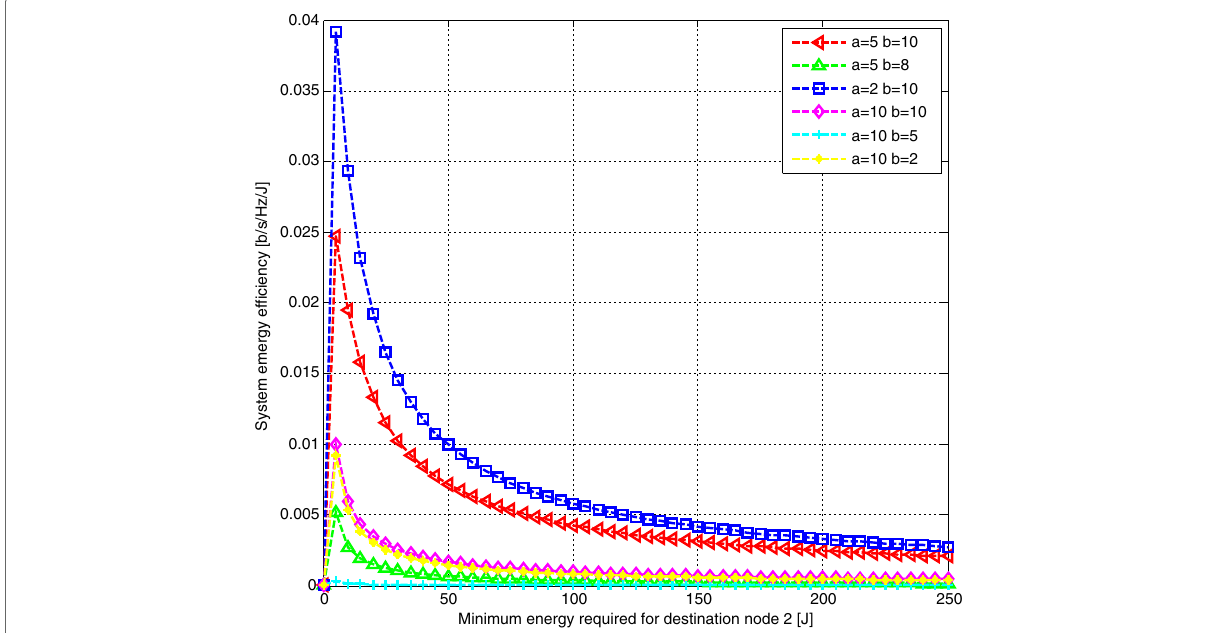
Fig. 4 Achieved energy efficiency of the whole IoT systems by the proposed scheme at the power splitting factor ρ =